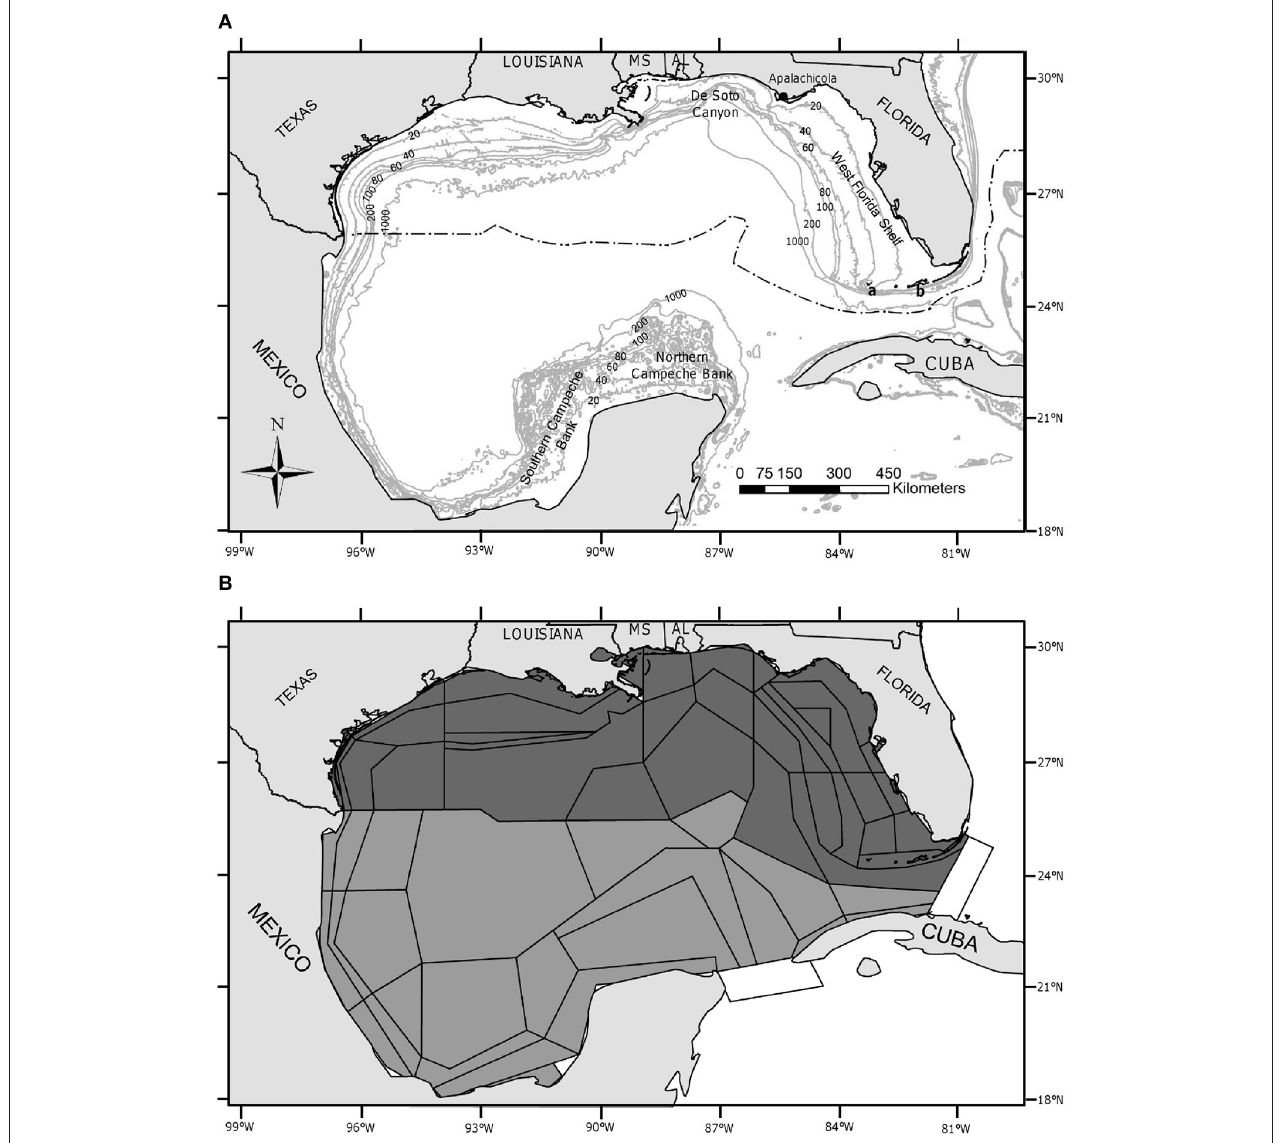
FIGURE 1 | Study area. (A) Map of the Gulf of Mexico Large Marine Ecosystem. Depth contours are labeled in 20-, 40-, 60-, 80-, 100-, 200-, and 1,000-m contours. Important features are labeled and include: the northern Campeche Bank, the southern Campeche Bank, the De Soto canyon, the West Florida Shelf, the Dry Tortugas (A) , and the Florida Keys (B) . MS, Mississippi; AL, Alabama. The black dashed-dotted line delineates the U.S. exclusive economic zone. (B) Spatial polygons of the Atlantis model of the Gulf of Mexico (GOM) referred to as “Atlantis-GOM”. Atlantis-GOM polygons located in U.S. GOM are filled in dark gray, while those located outside the U.S. GOM (i.e., in the Mexican or Cuban GOM or in international waters) are filled in lighter gray. The two “boundary polygons” of Atlantis-GOM, which do not interact with the rest of the model, are filled in